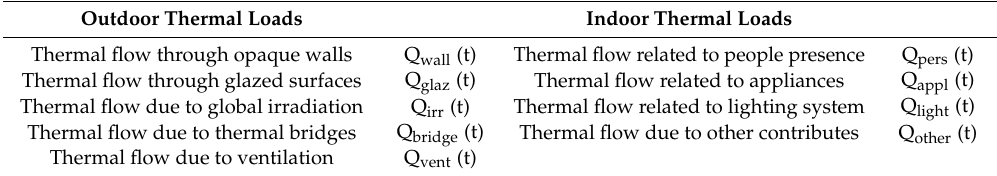
Table 4. Thermal loads considered in the Design Builder